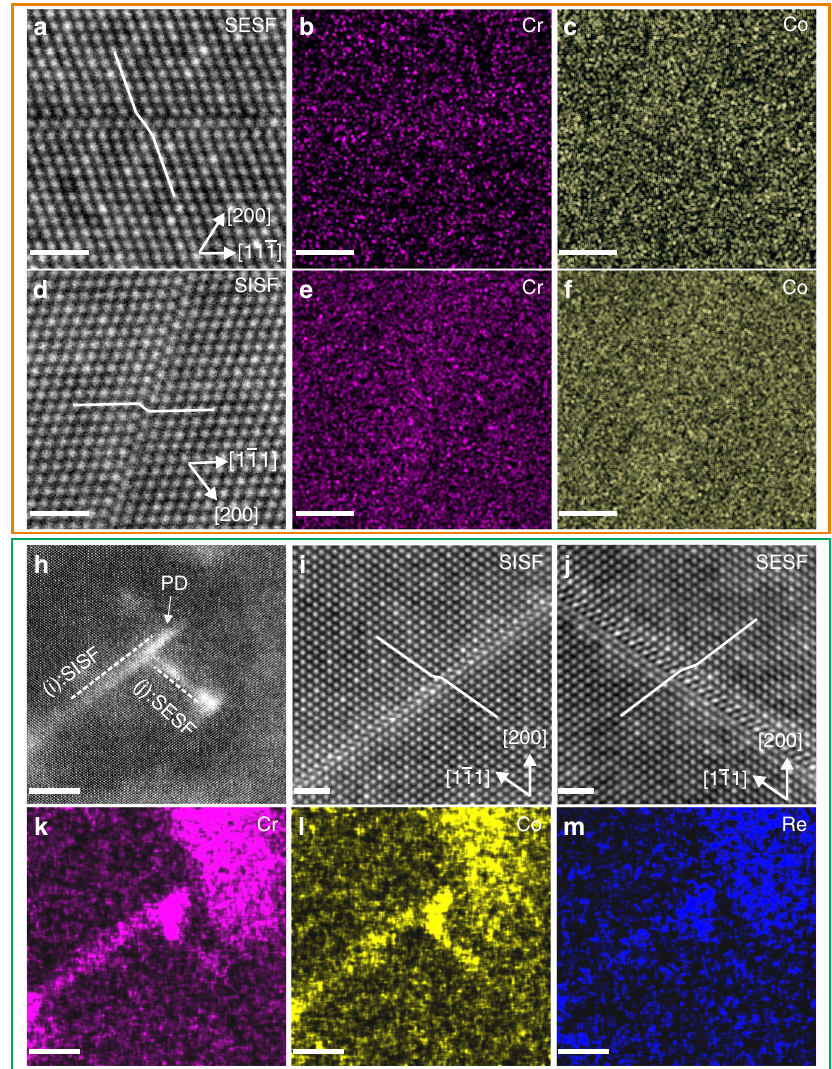
Fig. 2 Atomic-resolution STEM-EDX of SISF and SESF at 1 and 5% creep strains. 1% crept specimen: a HRSTEM HAADF image showing the atomic structure of a SESF; b Cr EDS mapping for ( a ); c Co EDS mapping for ( a ); d HRSTEM HAADF image of a SISF; e Cr EDS mapping for ( d ); f Co EDS mapping for ( d ). 5% crept specimen: h STEM LAADF image showing a PD, a SISF and a SESF; i HRSTEM HAADF image showing the atomic structure of the SISF; j HRSTEM HAADF image showing the atomic structure of the SESF; k Cr EDS mapping for ( h ); l Co EDS mapping for ( h ); m Re EDS mapping for ( h ). Scale bar: 1 nm for ( a – j ); 5 nm for ( k – m ). The colour intensity from EDS mapping is related to the composition in at%. Here, EDS mapping is used to provide a qualitative assessment, and the quantitative assessment comes from the APT measurement shown